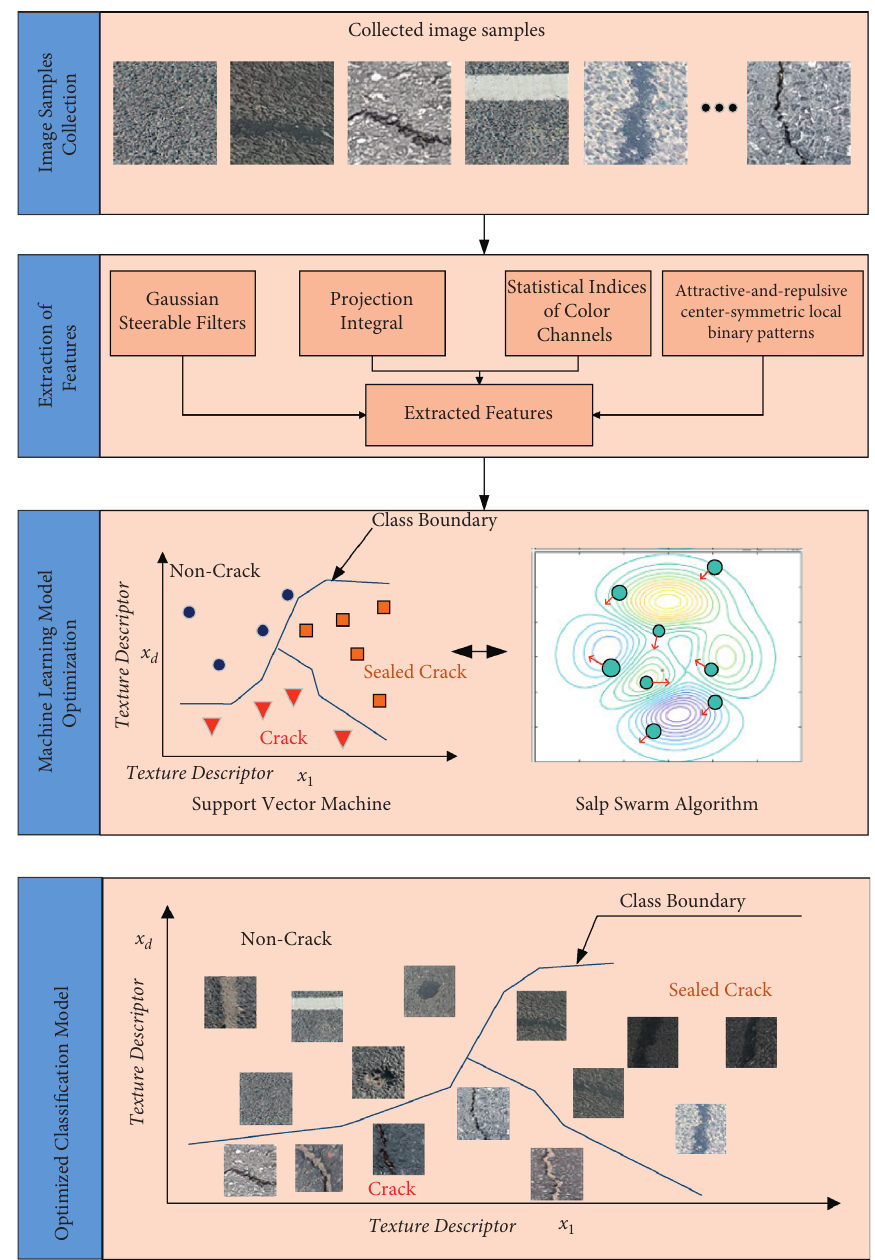
Figure 2: Research methodology